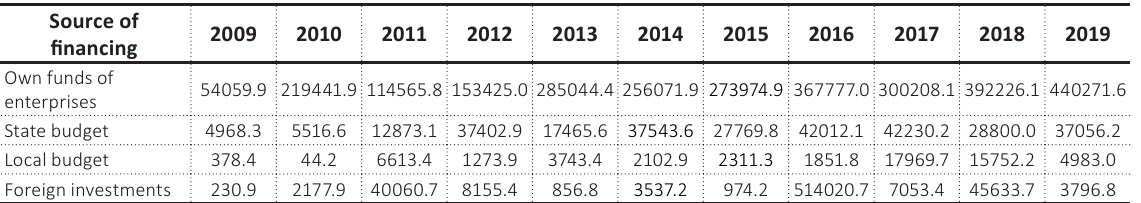
Table 3. Sources of financing for internal R&D expenditures for 2009–2019, in million KZT